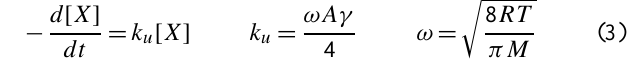
Fig.3. TimeseriesofIOmeasurements(23% 1 σ uncertainty,60minuteaverage,blackcircles)forthedurationofthecampaign.Alsoshown istheIOdetectionlimit(redline),tidalheight(blueline)and j (I 2 )(tenminuteaverage,orangeline). Fig. 3. Time series of IO measurements (23% 1 σ uncertainty, 60 min average, black circles) for the duration of the campaign. Also shown is the IO detection limit (red line), tidal height (blue line) and j (I 2 ) (10 min average, orange